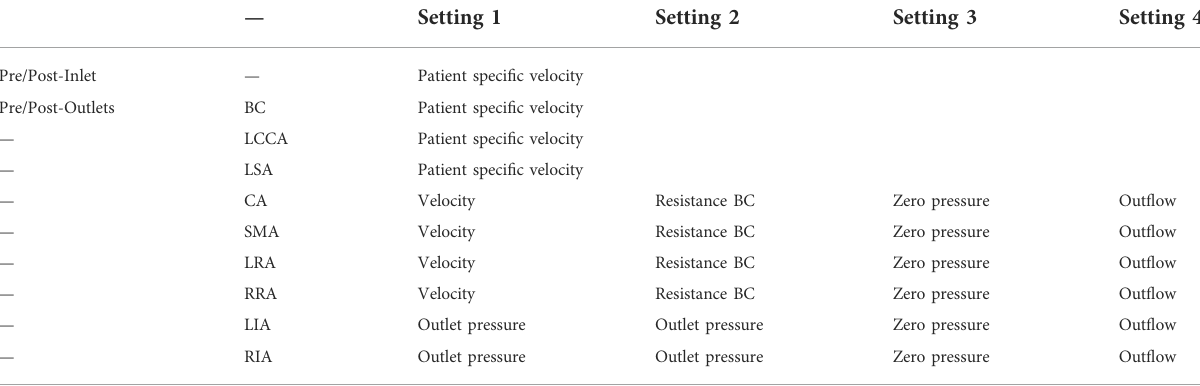
Model (ANSYS Inc, United States). The grid resolution varied between 2,500,000 and 3,000,000